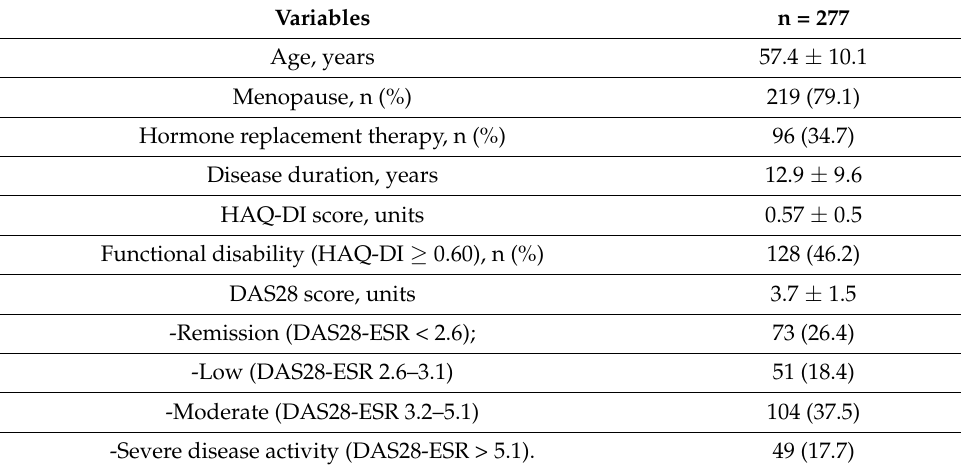
Table 1. Clinical characteristics in the patients with Rheumatoid Arthritis including in the